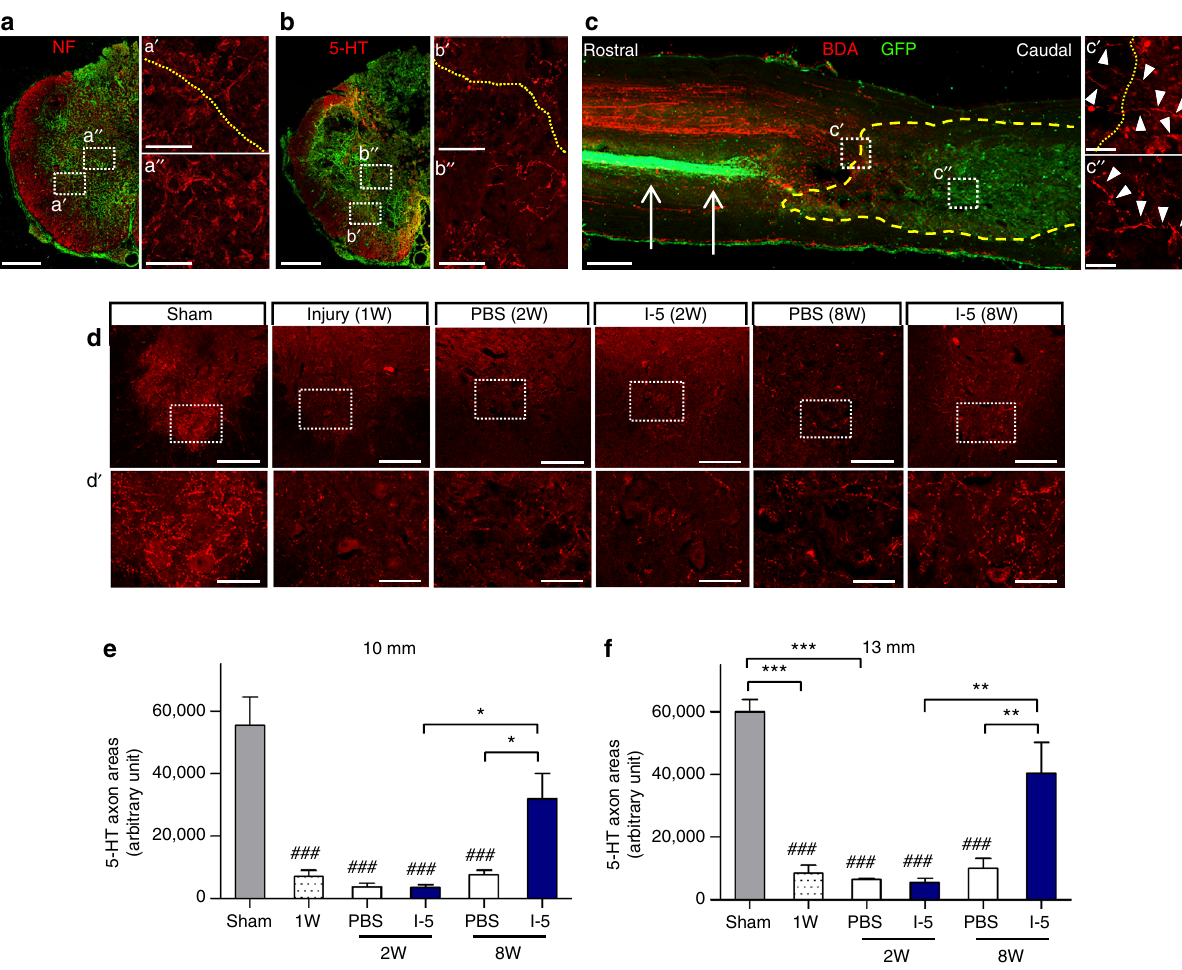
Fig. 10 I-5 supports axon growth and promotes axonal reinnervation. a , b NF positive ( a ) and 5-HT ( b ) axon growth in the FN-rich matrix in the tansverse spinal cord sections at the epicenter of the lesion in animals with I-5 injection. Red indicates NF ( a ) or 5-HT ( b ) and green indicates FN immunoreactivity. The boxed regions in a , b are magni fi ed in a ʹ , b ʹ and a ″ , b ″ . The dotted lines in a ʹ , b ʹ indicate the margins of the FN-rich matrix. Scale bars in a , b represent 500 µ m. Scale bars in the magni fi ed images represent 100 µ m. c A representative image of the longitudinal spinal cord section from an animal with I-5 hydrogel. Descending axons were traced with AAV8-GFP and biotinylated dextran amine ( BDA ). The tissue section was stained with Alexa Fluor 594-conjugated streptavidin ( red ) and FN antibody ( green ). The corticospinal tract ( arrows ) was visualized by GFP signal. The yellow dashed line indicates the boundary of the FN-rich matrix. Boxed regions were magni fi ed in c ʹ , c ″ . Arrowheads indicate BDA-traced axons. The scale bar in c represents 500 µ m and the scale bars in c ʹ , c ″ represent 50 µ m. d 5-HT axon innervation in the ventral motor regions of the lumbar spinal cord in sham-operated animals, animals with injury alone sacri fi ced 1 week (W) after injury, animals with PBS or I-5 injection sacri fi ced 2W or 8W after injury. The boxed regions in d are magni fi ed in d ʹ . Scale bars in d , d ʹ represent 500 and 100 µ m, respectively. e , f Quanti fi cation of 5-HT axon density in the ventral motor regions in the lumbar spinal cord. Quanti fi cation was done at 10 mm ( e ) or 13 mm ( f ) caudal to the epicenter. * and *** indicate p < 0.05 and p < 0.001 by one-way ANOVA followed by Tukey ’ s post hoc analysis. ### indicates p < 0.001 compared to sham-operated group by one-way ANOVA followed by Tukey ’ s post hoc analysis. N = 5, 4, 4, 5, 9 and 8 for the sham-operated, PBS (1W), PBS (2W), I-5 (2W), PBS (8W), or I-5 (8W) groups, respectively. Error bars represent the SEM (CDCl3), δ (ppm): 0.8 – 1.0 (s, 6H), 1.1 – 1.3 (b, 3H), 1.3 – 1.6 (b, 2H), 1.6 – 1.9 (b, 1H), assay (Pierce). High performance of liquid chromatography (HPLC) system 2.5 – 2.8 (b, 4H), 2.6 – 2.9 (b, 49H), 2.8 – 3.3 (b, 2H), 3.4 – 3.8 (b, 75H), 3.9 (s, 1H), (Agilent, 1050 series) was also used to con fi rm the conjugation of imidazole. The 4.0 – 4.3 (b, 5H), 6.9 – 7.2 (b, 1H), 7.4 – 7.6 (b, 1H), 7.9 – 8.1 (s, 1H). molecular weight of I-5 was calculated by using a gel permeation chromatography system (Waters 1515, Waters) with a refractive index detector (Waters 2410) and two styragel columns (Waters styragel HR 4E and HR 5E) connected in line at a Preparation of I-5 hydrogel solution . Ten percent (by weight) of the I-5 polymer fl ow rate of 1ml/min at 35 °C. THF containing 0.1% (by weight) tetra- in PBS solution was used for experiments after fi ltration using 0.2 µ m cellulose butylammonium bromide was used as a mobile phase. Polystyrenes (MW: 1270; acetate syringe fi lter. In the experiments where I-5 polymer solution had to be 3760; 12,900; 28,400; 64,200; 183,000; 658,000; 1,050,000; 2,510,000; 3,790,000) mixed with Taxol or siRNA nanoparticles, 20% (by weight) of I-5 solution was were used as standards. The viscosity of the aqueous I-5 polymer solution was prepared. measured by using a Brook fi eld RVDV-III + viscometer (Brook fi eld) between 5 and 70 °C under a fi xed shear rate of 0.1 per s. The viscosity measurements were done Measurement of the physical properties . The structure of prepared polymers with a set spindle speed of 0.2 rpm and with a heating rate of 0.33°C/min. For was estimated by a 1 H-NMR spectrometer (Varian Gemini-300, Agilent Tech- in vitro stability test, 10% polymer solutions were mixed with a fl uorescence dye nologies) operating at 400 MHz in the Fourier transform mode with CDCl 3 used as Rhodamine B (at a concentration of 10 μ g of 100 μ 1), and 200 μ 1 of labeled the solvent and by an FT-IR spectrometer (Spectrum GX FT-IR, Perkin-Elmer). polymer solution was loaded onto a millicell (pore size 12.0 μ m). The millicells The substituted amount of imidazole groups in IP was also determined by BCA NATURE COMMUNICATIONS | 8: